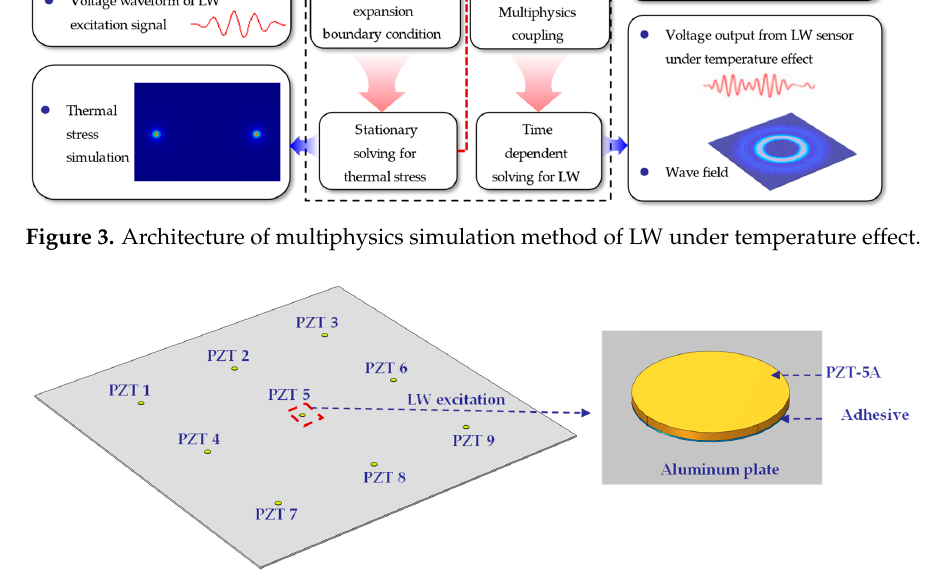
Figure 4. LW propagation under temperature effect simulation model.